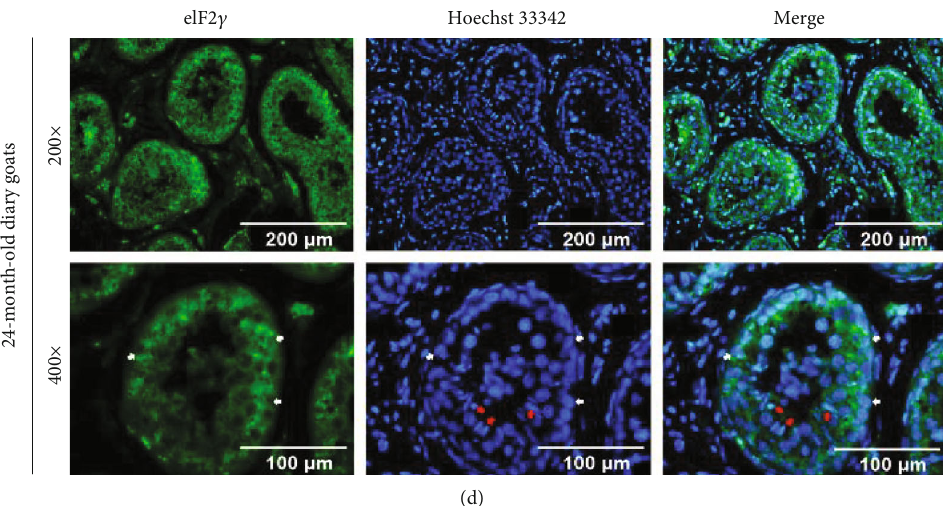
Figure 1: The expression pattern of Eif2s3y in dairy goats. (a) Real-time PCR analysis of Eif2s3y expression levels in di ff erent tissues of adult dairy goats. All results were compared with the testis. (b) Real-time PCR analysis of Eif2s3y expression levels in the testes of dairy goats of di ff erent ages. All results were compared with that of 1-month-old goats. (c) Immuno fl uorescence staining of eIF2 γ in the testes of 3- month-old dairy goats counterstained with Hoechst 33342. The white arrows indicated typical SSCs. Scale bars, 200 μ m (up) and 100 μ m (down). (d) Immuno fl uorescence staining of eIF2 γ in the testes of 24-month-old dairy goats counterstained with Hoechst 33342. The white arrows indicated typical SSCs, and the red arrows indicated typical sperms. Scale bars, 200 μ m (up) and 100 μ m (down). Data are presented as mean ± SD and are represented by three independent repetitions; ∗ P < 0 : 05 , ∗∗ P < 0 : 01 , and ∗∗∗ P < 0 : 001